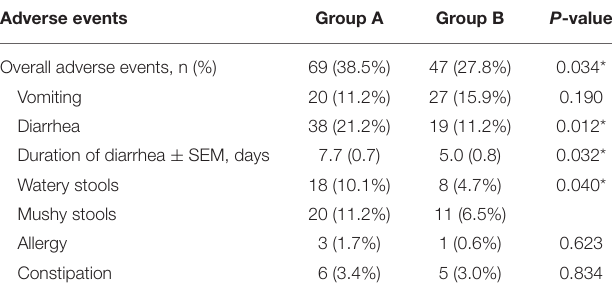
TABLE 3 | Comparison of incidence of AEs between two groups. Adverse events Group A